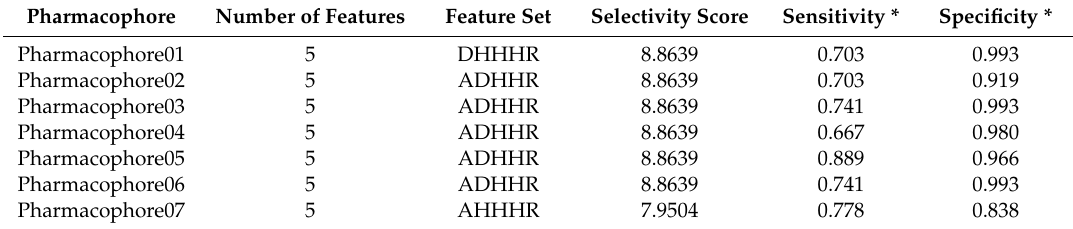
Table 1. Seven generated pharmacophore models.